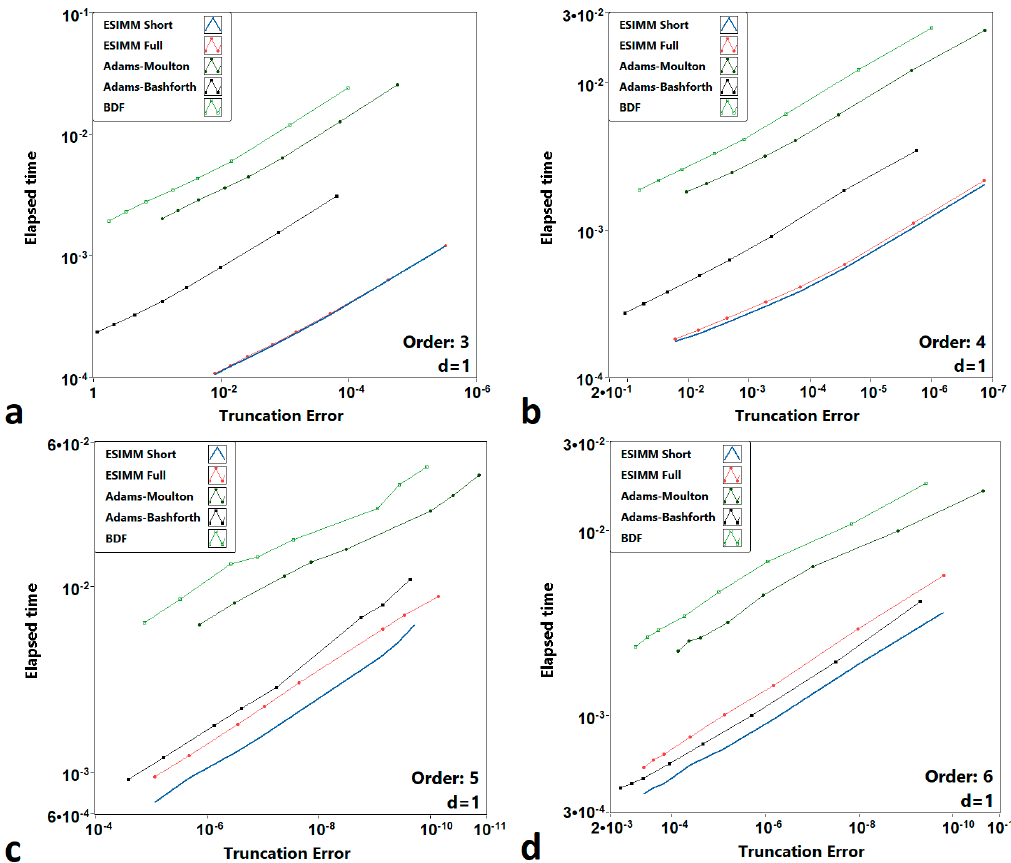
Figure 5. Performance plots for simulating Sprott Case E system by various multistep methods with the accuracy ( a ) order 3, ( b ) order 4, ( c ) order 5 and ( d ) order 6.